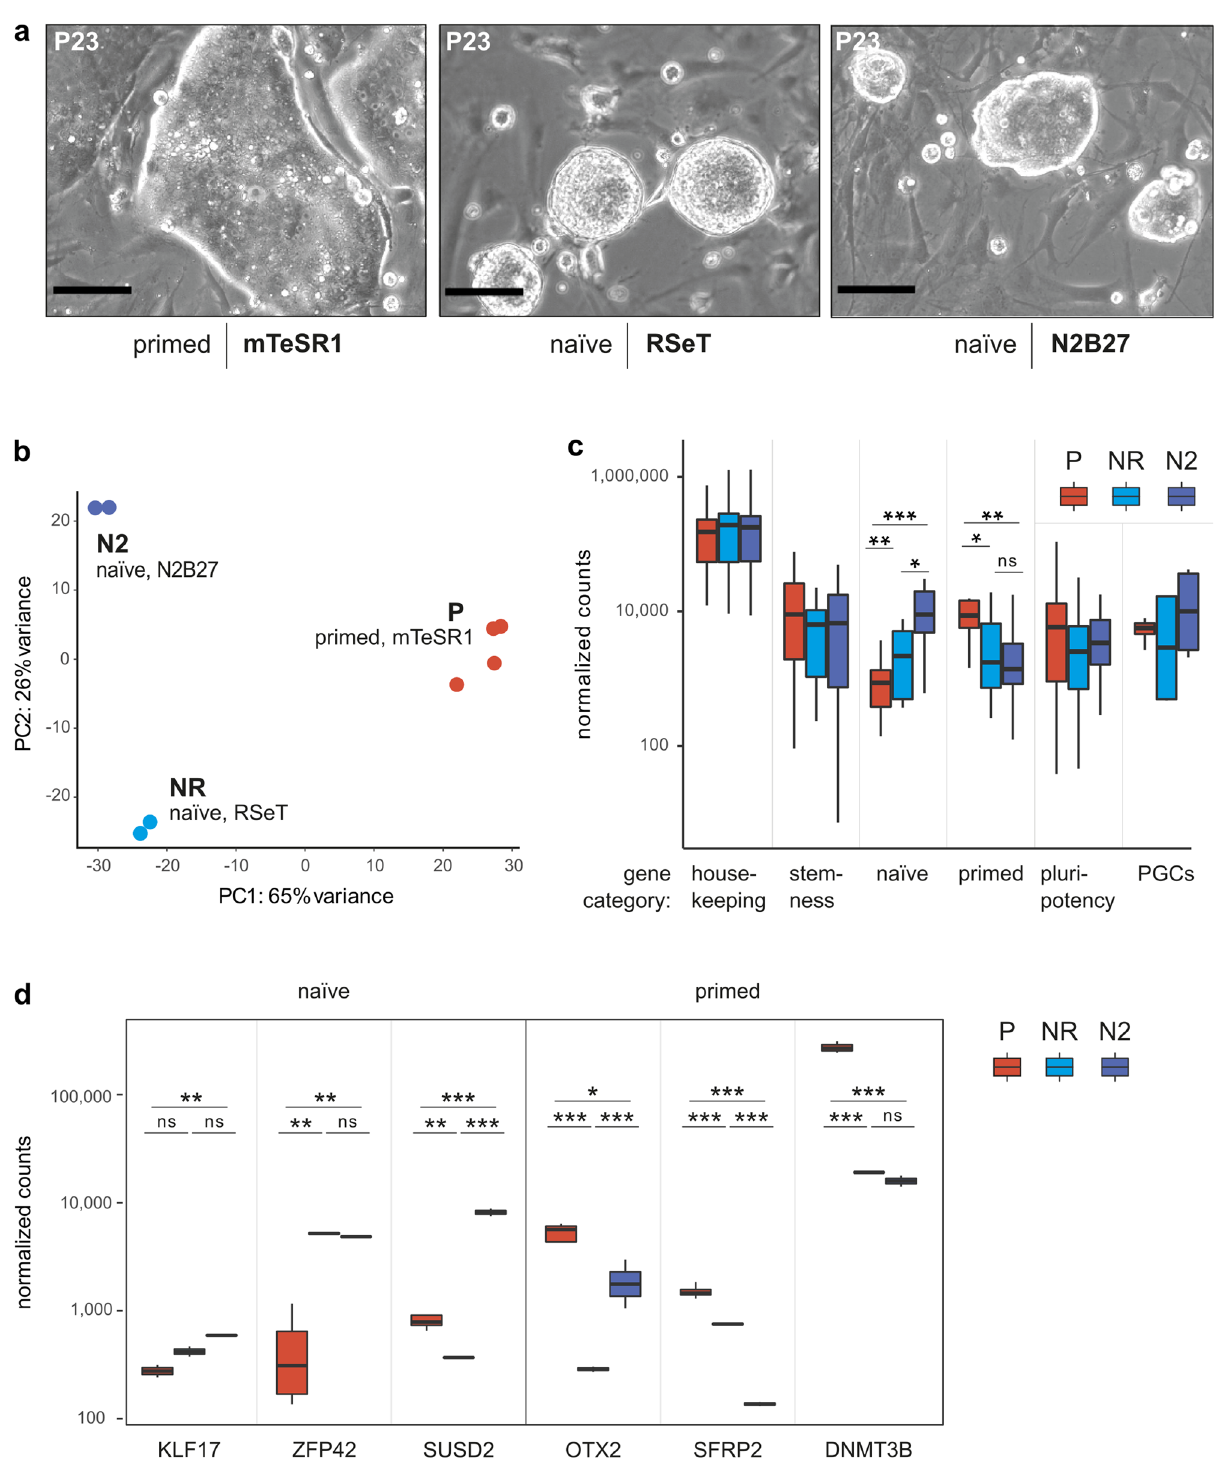
Figure 3. NWR iPSCs adopt naïve-like pluripotency. See also Supplementary Fig. S5 and Supplementary Table S1. ( a ) Representative images showing the cell morphology of NWR iBCL2-GFP-iPSCs grown on mouse embryonic fibroblasts in primed mTeSR1 (left) , and naïve conditions: RSeT (middle) and N2B27 (right) medium. Scale bars: 200 µm. ( b ) Principal component analysis (PCA) of transcriptome data from NWR iPSCs and NWR iBCL2-GFP- iPSCs cultured in primed and naïve conditions. ( c ) Comparative gene expression analysis of NWR iPSCs and NWR iBCL2-GFP-iPSCs cultured in primed and naïve conditions. Selected genes were grouped into categories and the average normalized expression counts were compared across samples. *, **, ***P value < 0.05, 0.01, 0.001, respectively (Wilcoxon test). Marker genes are provided in Supplementary Table S1. ( d ) Expression of marker genes in NWR iPSCs and NWR iBCL2-GFP-iPSCs cultured in primed and naïve conditions. *, **, ***P value < 0.05, 0.01, 0.001, respectively (adjusted P values DEseq2). ns not significant, NR, N2 NWR iBCL2-GFP-iPSCs, naïve conditions, RSeT and N2B27 protocols, respectively, P NWR iPSCs primed conditions